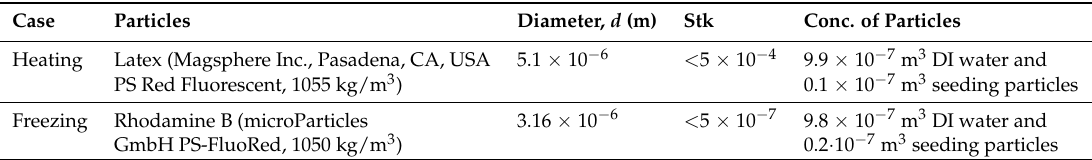
Figure 2. Schematic diagram of the experimental setup. Table 1. Data of seeding